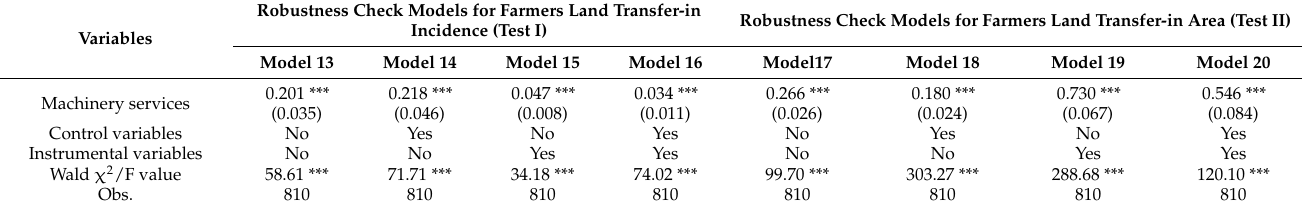
Table 5. Robustness test